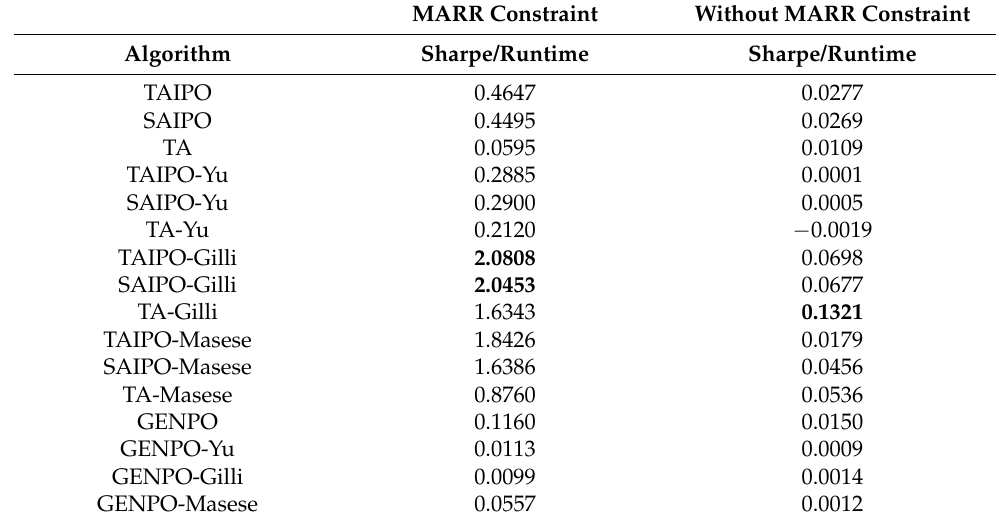
Table 5. Sharpe Ratio vs. Runtime.